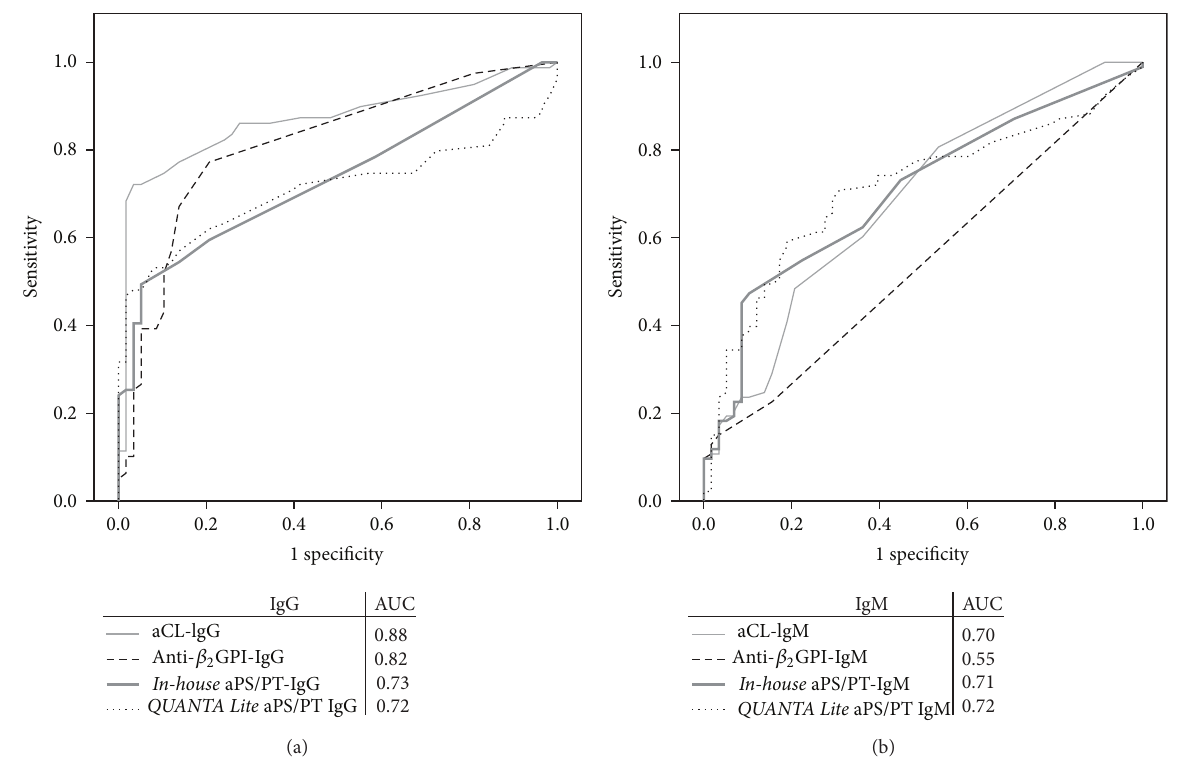
Figure 2: Receiver Operating Characteristic (ROC) curves and area under the curve (AUC) of different antiphospholipid antibody methods for APS ( 𝑛 = 156 ). The higher values of AUC indicate better diagnostic efficiency of the test. aCL: anticardiolipin, anti- 𝛽 2 GPI: anti- 𝛽 2 glycoprotein, and aPS/PT